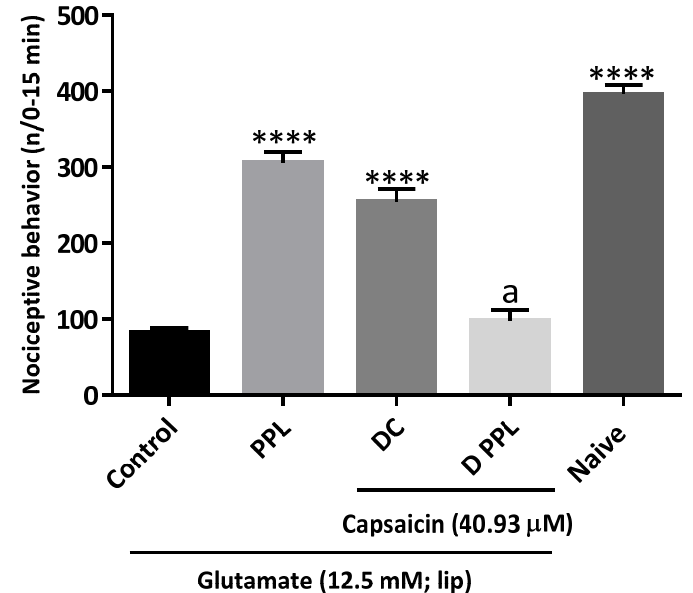
Figure 3. Involvement of the central afferent fibres sensitive to capsaicin (TRPV1) on the antinociceptive effect of PPL in adult zebrafish. Each column represents the mean ± S.E.M. (n = 6/group). ANOVA followed by Tukey test. **** p < 0.001 vs Control and a p < 0.0001 vs PPL, Control and Naive. DC = Desensitized Control; D PPL = Desensitized PPL (0.05 mg/mL); PPL = 0.05 mg/kg PPL.